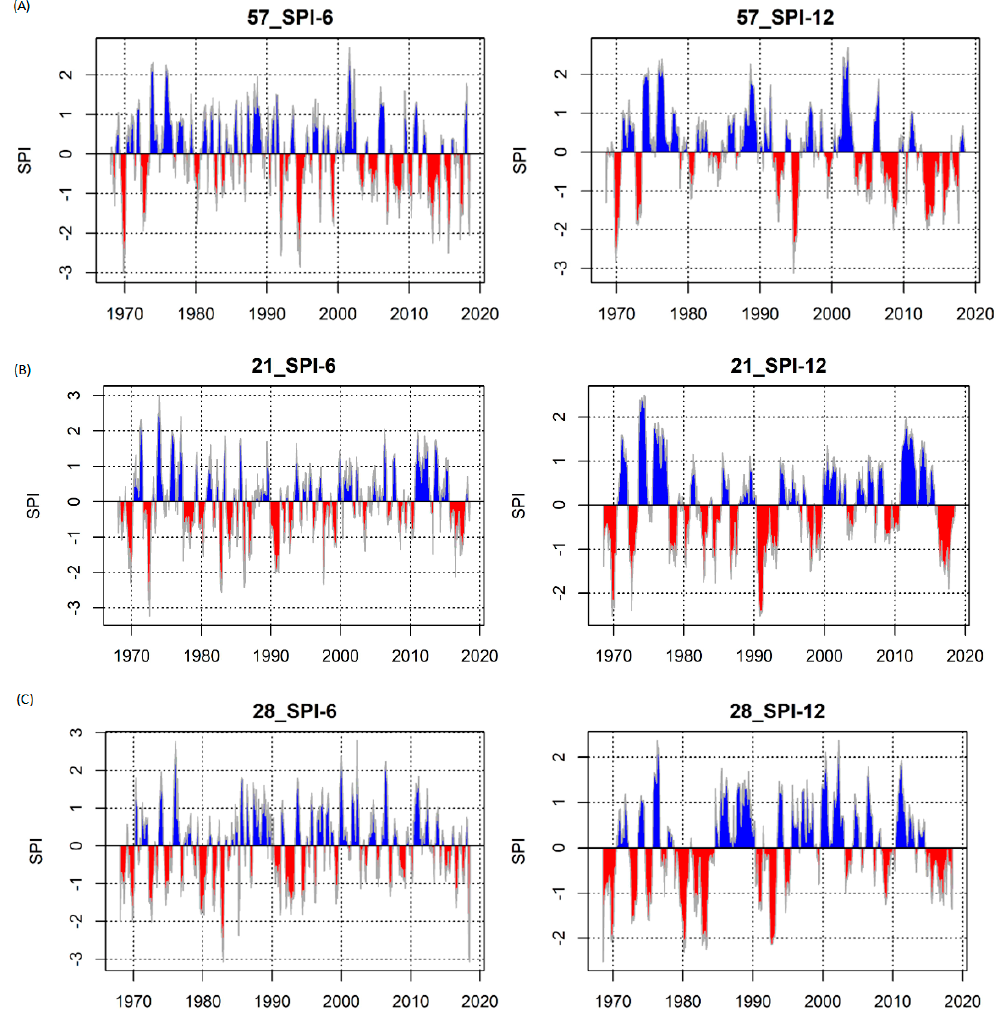
Figure 2. Standardized Precipitation Index (SPI time series for selected climatic rainfall districts in ( A ) north-western, ( B ) south, and ( C ) south-eastern regions of the Eastern Cape province. Left panel: SPI-6 and right panel: SPI-12. The blue and red colors represent wet and dry epochs, respectively.